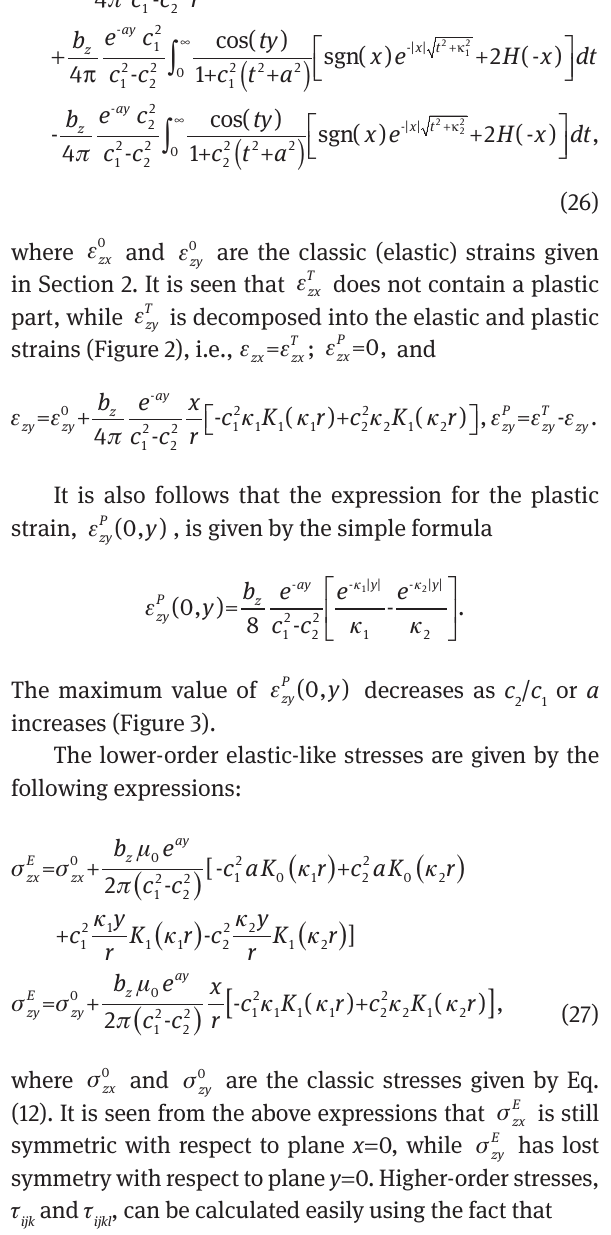
and τ are singular in the first strain zxy zyx